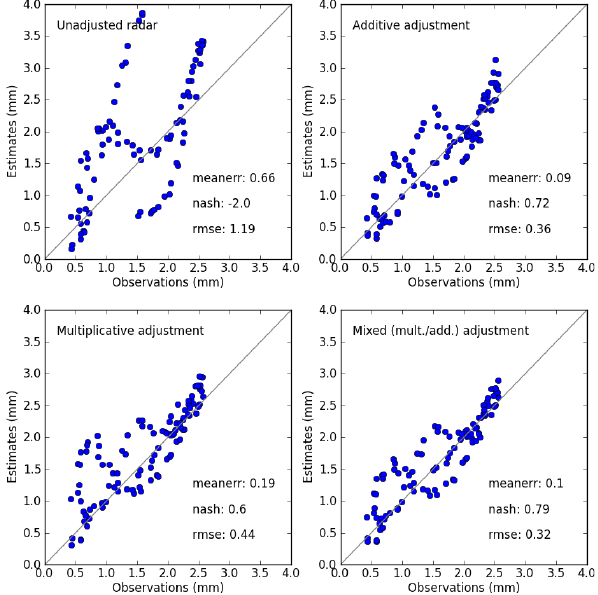
Fig. 6. Verification of the adjustment techniques, using the example shown in Fig. 5. The scatter plot and the error metrics were created using wradlib.verify. The metrics are computed by comparing the unadjusted and the adjusted radar observations against the synthetic true rainfall (just a small selection of error metrics is shown